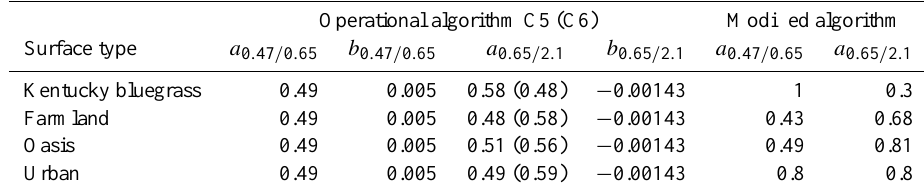
Table 4. Overview of the slopes and intercepts for the calculation of the surface reflectance ρ s , 0 . 46 and ρ s , 0 . 47 following Eqs. (1) and (2) for different surface types used in the operational and modified algorithms C5 and C6. The C6 parameters are given in brackets when they differ from the C5 approach.